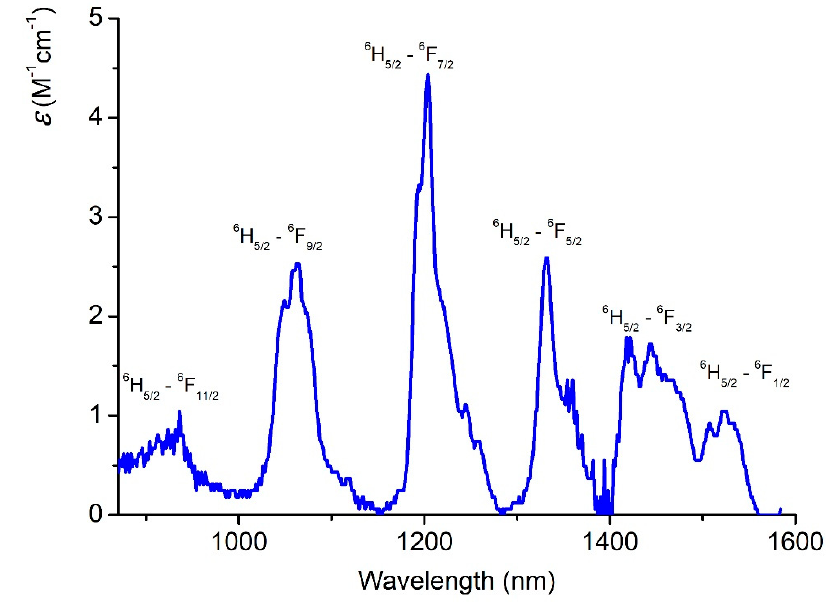
Figure 6. NIR absorption spectrum of complex 4 in THF solution.